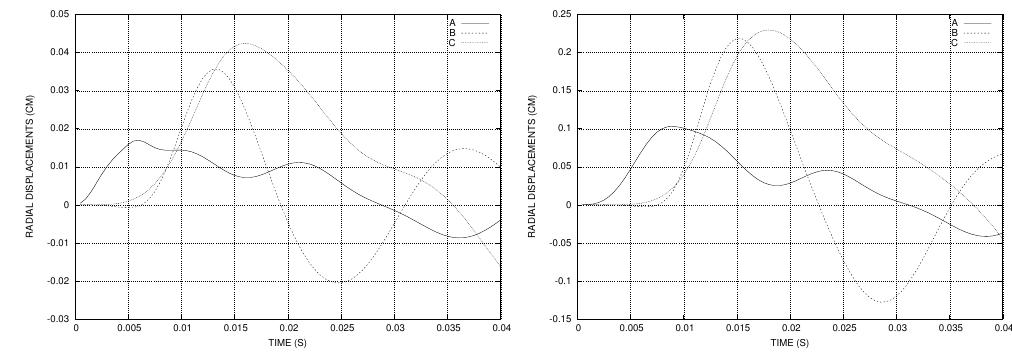
Figure 6. The time history of the displacement of three points on the interface using constant ( left ) and sin-like ( right ) stress at the inlet.